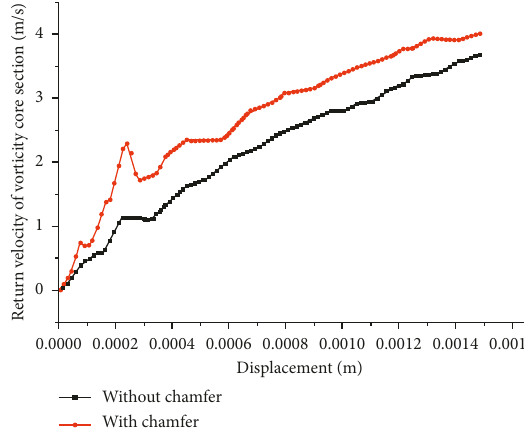
Figure 23: Velocity distribution in the reflux zone of vortex center.